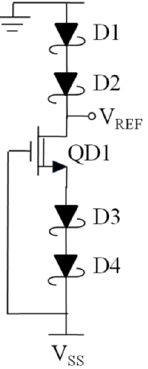
Figure 1. Schottky-diode-based GaN voltage reference [29].